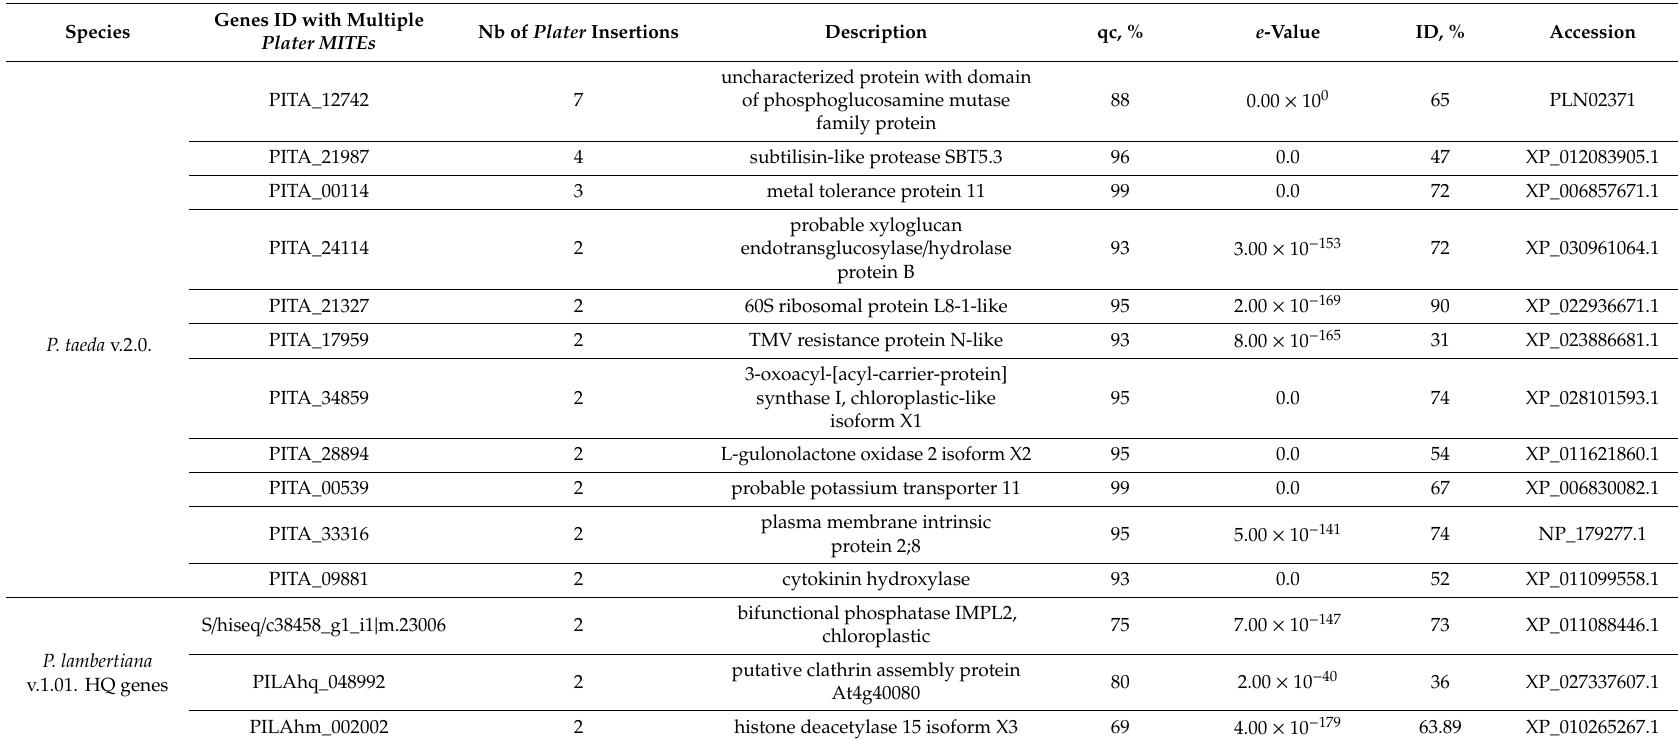
Table 2. P. taeda v.2.0 and P. lambertiana v.1.01 genes carrying several Plater MITE insertions. qc- query